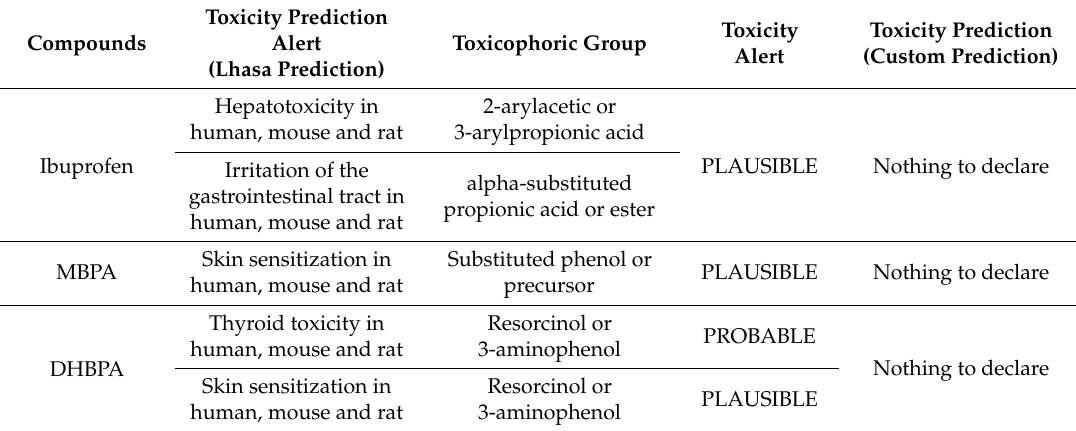
Toxicity Toxicity Prediction Alert (Custom